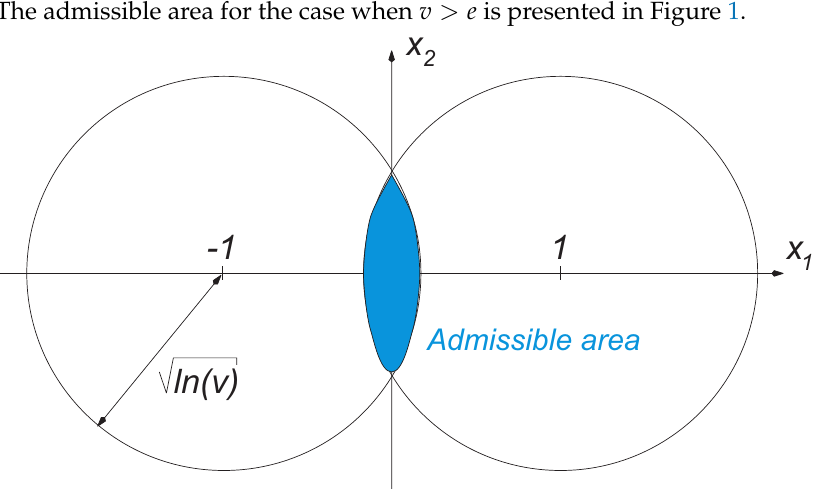
Figure 1. Cross-section through the admissible set in the problem (105)–(109) for v > e